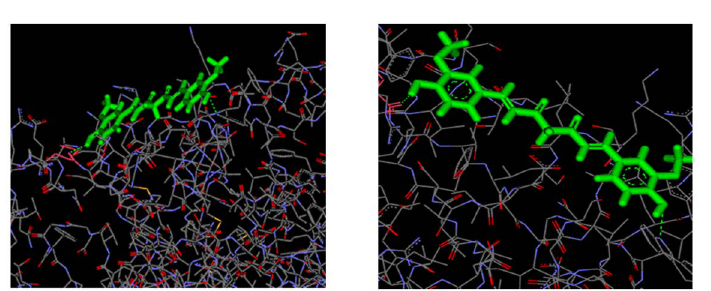
Fig. 5. Molecular docking of curcumin against ENR (enoyl carrier protein